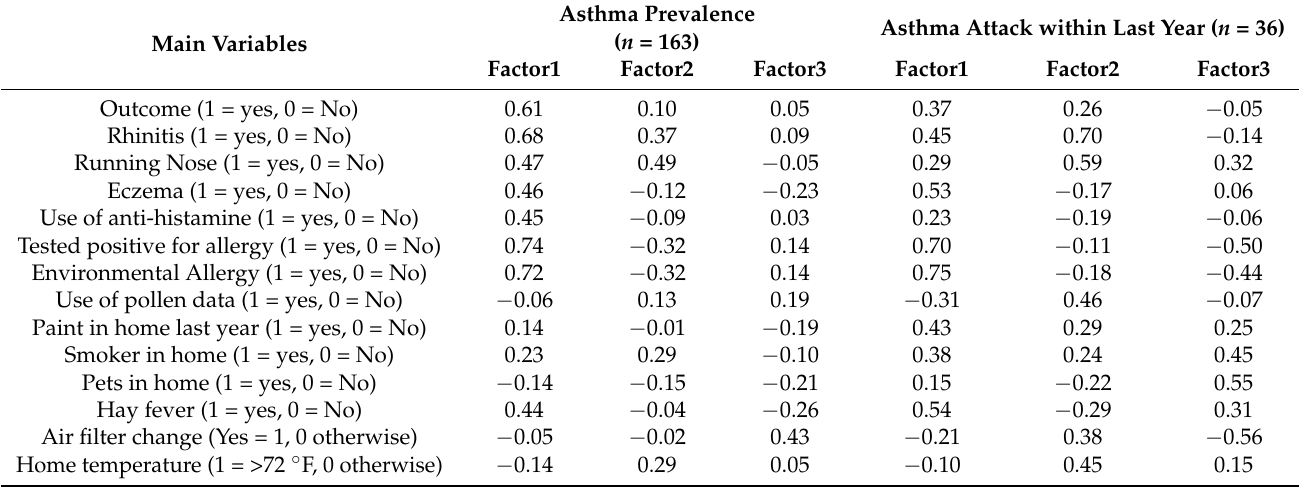
Table 5. Factor loadings with main outcome variables.